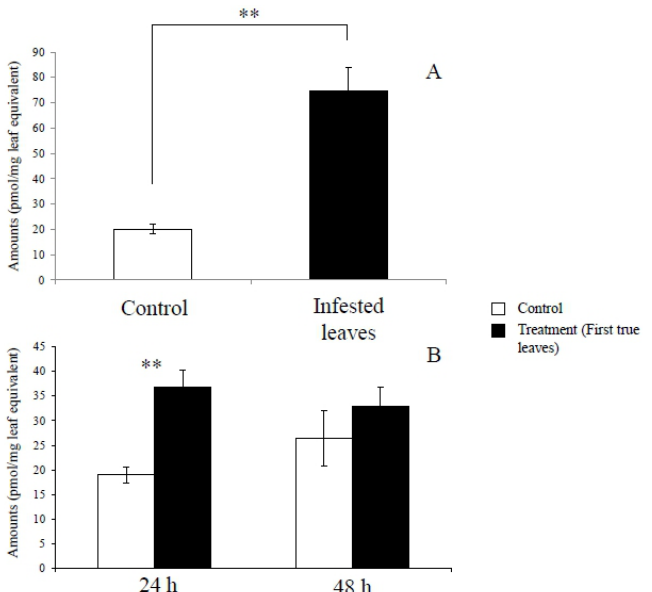
Figure 5. Amounts of induced phenylalanine in soybean leaves infested by S. litura larvae in 24 hours after the removal of larvae ( A ) and treated with gut contents of S. litura ( B ) in 24 and 48 hours after the treatment. The data were analyzed using the Student’s t -test and are presented as the mean ± S.E.M. (n = 3–4). Asterisks indicate significant differences (*, p < 0.05; **, p < 0.01) relative to the